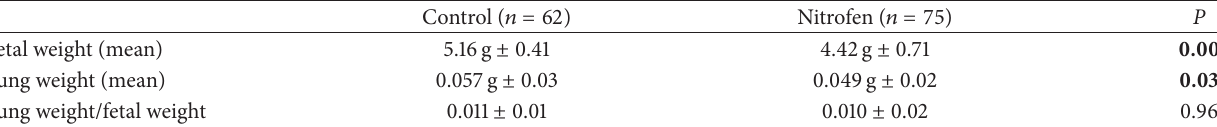
Table 1: Comparison of mean weight by group (control versus nitrofen).